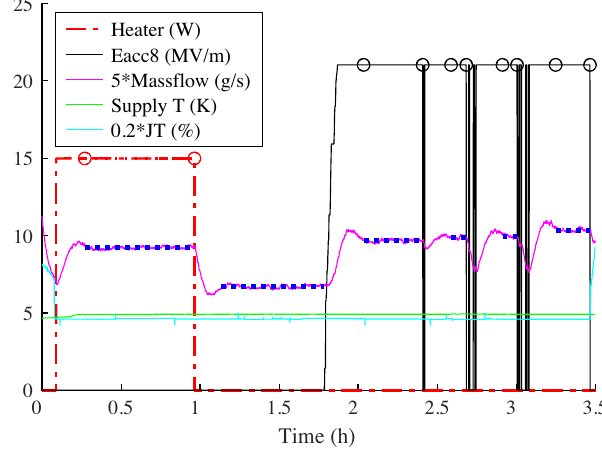
FIG. 13. Data recorded during the Q 0 measurement of cavity 8. Multiple quenches occurred during the process, but there were stable intervals long enough that allowed multiple Q 0 measure- ments to be made. This plot also shows the heater and static load calibration steps. The regions where the mass flow was evaluated are highlighted with circles and dotted blue lines. The helium inlet conditions (Joule Thomson valve setting and supply temper- ature) were held as constant as possible during this